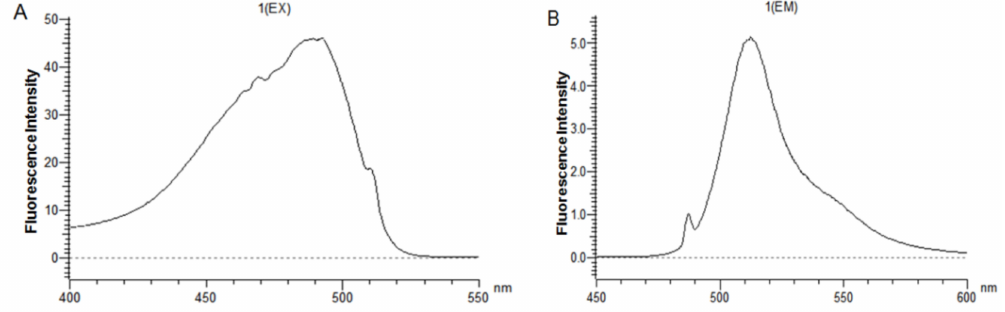
Figure 7. Scanning the ( A ) excitation wavelength and ( B ) emission wavelength of CL7-sfGFP in TBS bu ff er (pH 7.6).